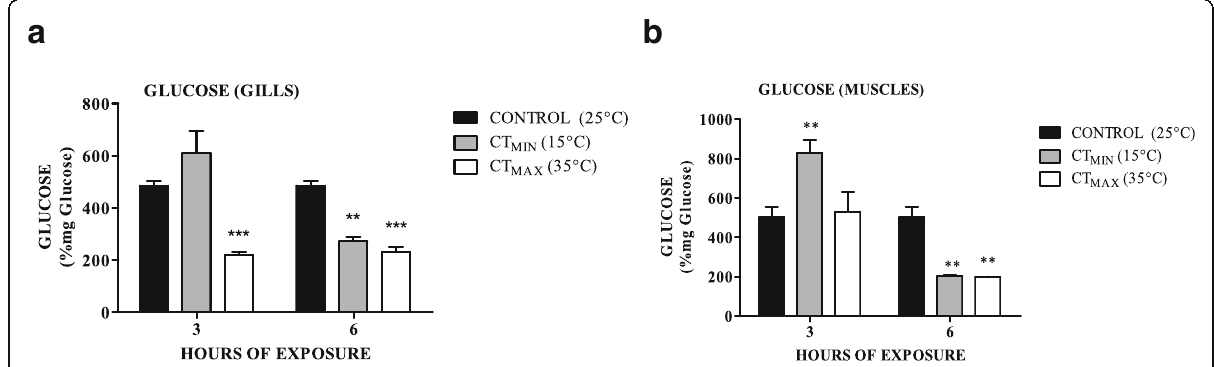
Fig. 5 Effect of temperature on the activity of Glucose in the gills ( a ) and muscles ( b ) of Koi carps. Significance was calculated by two-way ANOVA followed by Bonferroni post-test where p < 0.001 (***); p < 0.01 (**). The vertical lines indicate mean ± SE. Bars represent different periods of